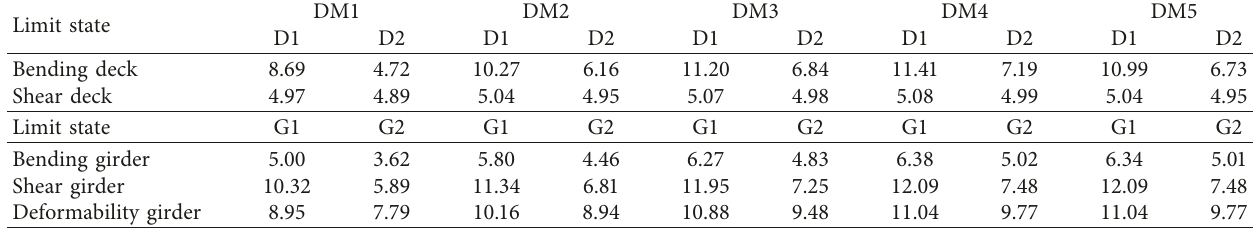
Figure 15: (a) Expected total costs of the two design alternatives compared with the corresponding initial costs; (b) total cost increase with respect to initial cost in design alternative 1 and (c) and total cost increase with respect to initial cost in design alternative 2. Table 6: Minimum β indexes for the two design alternatives and for t 30years for different degradation models. (cid:28)